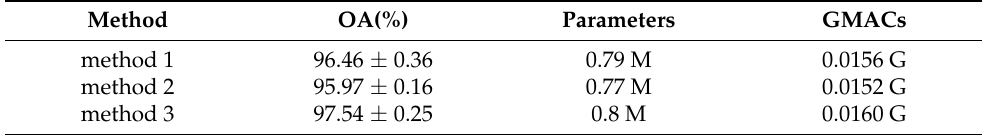
Figure 10. Visualization results of feature maps. ( a ) The original remote sensing scene image. ( b ) Visualization results of shallow features. ( c ) Visualization results of deep features. Table 12. Comparison results of feature extraction ability of three